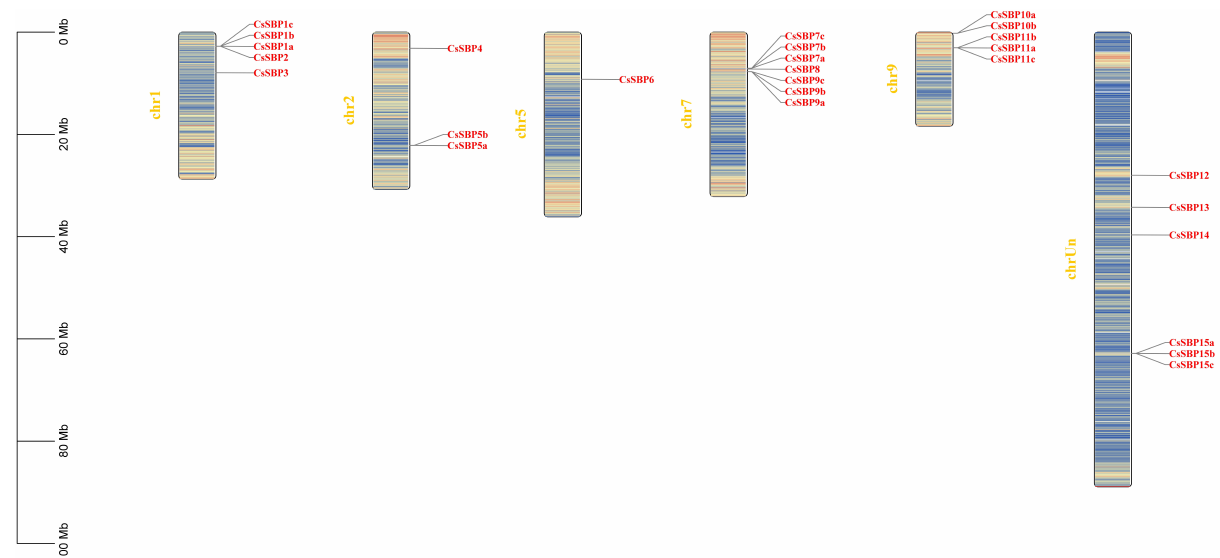
Figure 1. Phylogenetic tree of Citrus sinensis , Arabidopsis thaliana , and Oryza sativa SBP proteins. The tree was constructed from amino sequences using MEGA-X software by the neighbor-joining program with 1000 bootstrap replicates. Clades with different colors represent diverse subgroup.